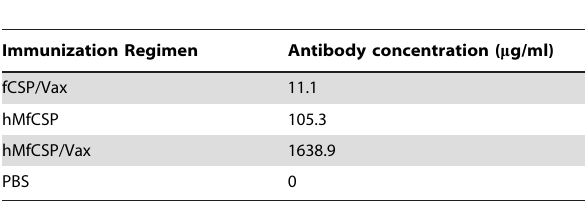
Table 3. CSP-specific Antibody Concentration in Pooled Sera from Different Groups of Immunized